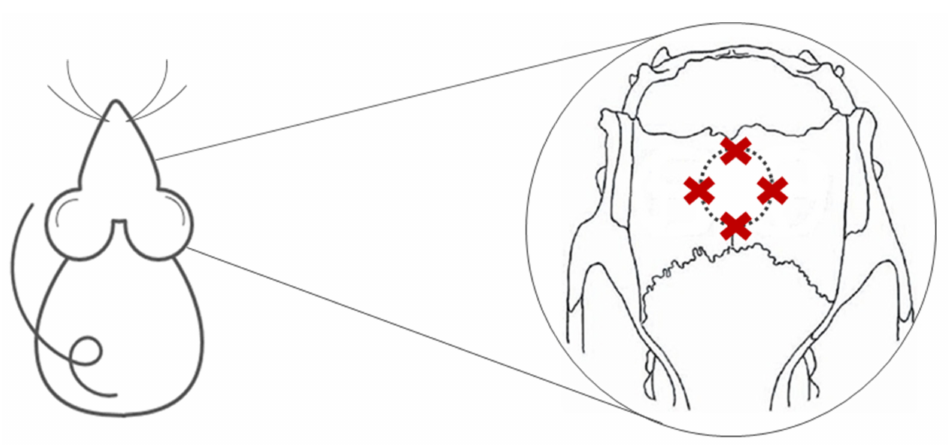
Figure 8. Demonstration of the four points of PBMT application at the defect margins